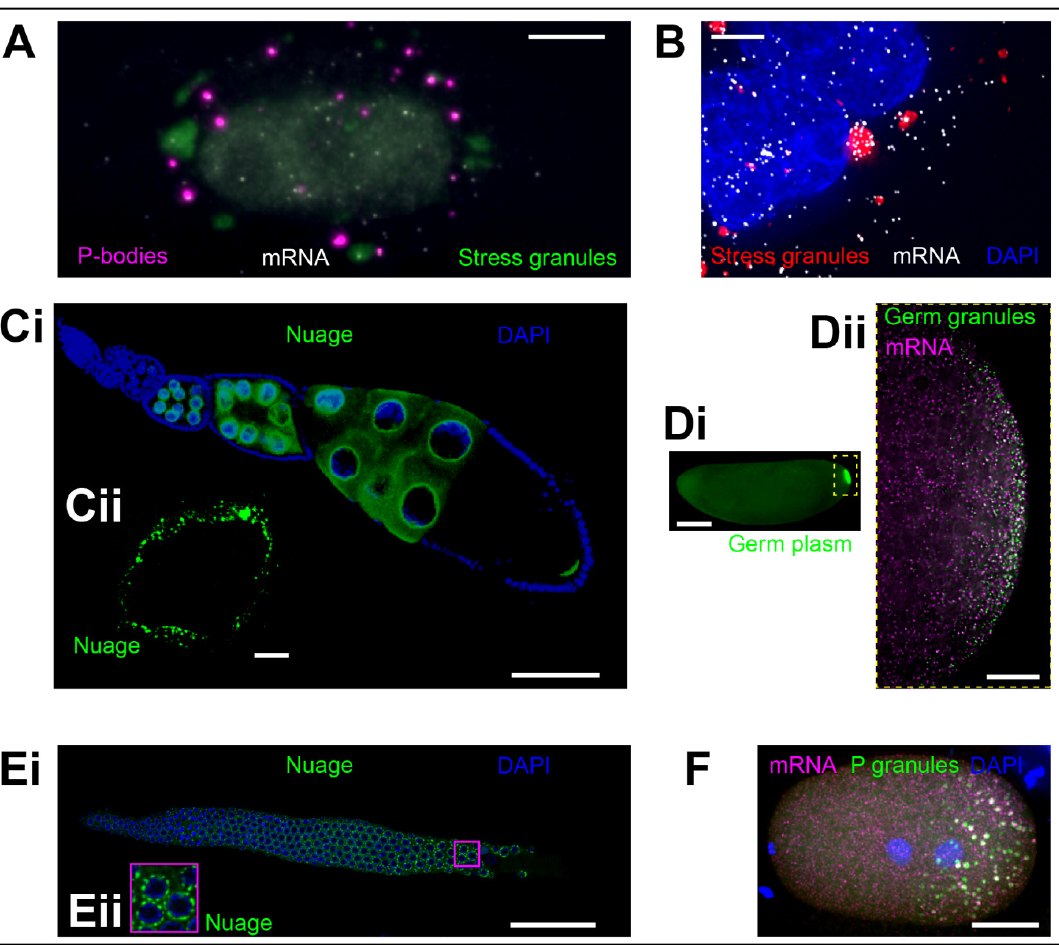
Figure 1. ( A ) Processing bodies (P-bodies) (magenta, marked by DDX6 fused with TagRFP) interacting with stress granules (green, marked by G3BP1 fused with GFP) in U2OS cells during stress. mRNAs (a transgenic mRNA genetically-tagged with MS2:MCP-Halo) are shown as white dots. Image: Courtesy of Jeff A. Chao (FMI). ( B ) Stress granules (red; marked by G3BP1 fused with GFP) accumulate AHNAK mRNA (white, hybridized with smFISH probes) in U2OS cells during stress. Nuclei are labeled with a DAPI stain. Image: Courtesy of Stephanie Moon (University of Michigan) and Roy R. Parker (University of Colorado, Boulder). ( Ci , ii ) Nuage (green, marked by Vasa fused with GFP) abutting the nurse cell nuclei (blue, marked by DAPI) in Drosophila oocytes. ( ii ) Shows a close-up of a single nucleus from a different oocyte from the one shown in ( i ). ( Di , ii ) Germ granules (polar granules) ( ii ) form within germ plasm ( i ) at the posterior pole of the early Drosophila embryo (green; marked by Vasa fused with GFP). mRNAs such as gcl (magenta, hybridized with smFISH probes) enrich in these granules. ( Ei , ii ) Nuage (( ii ) magenta square: Close-up of three nuclei) (green, marked anti-CSR-1 antibody) abutting the C. elegans germ cell nuclei (blue, marked by DAPI). Image: Courtesy of Jessica Kirshner and John K. Kim (Johns Hopkins University). ( F ) mRNAs in P granules are enriched in the C. elegans one cell zygote. P granules enrich polyA RNA (green) and nos -2 mRNA (magenta), both marked with smFISH probes. DNA is stained with DAPI (blue). Image: Courtesy of Madeline Cassani, Andrew Folkmann, and Geraldine Seydoux (John Hopkins School of Medicine). Scale bar in A , B , Cii is 5 µm, in Dii , F is 10 µm, in Ci , Ei is 50 µm, and in Di is 100 µm.